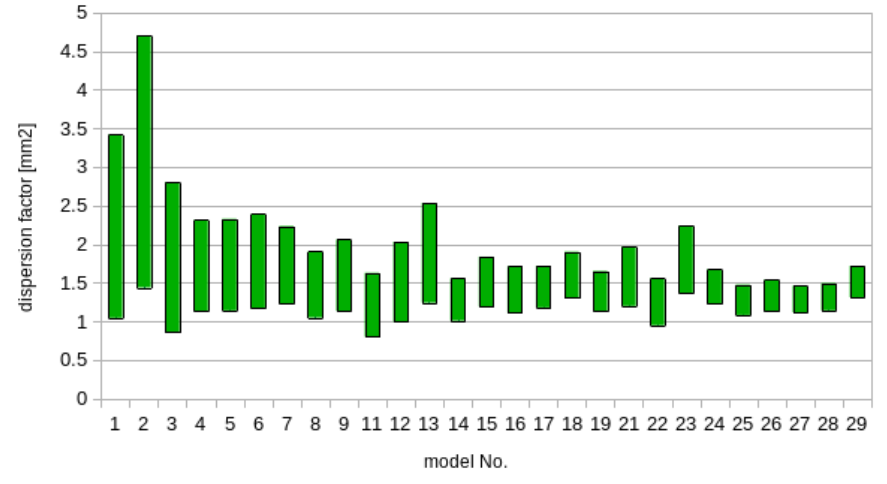
Figure 9. Confidence intervals for dispersion